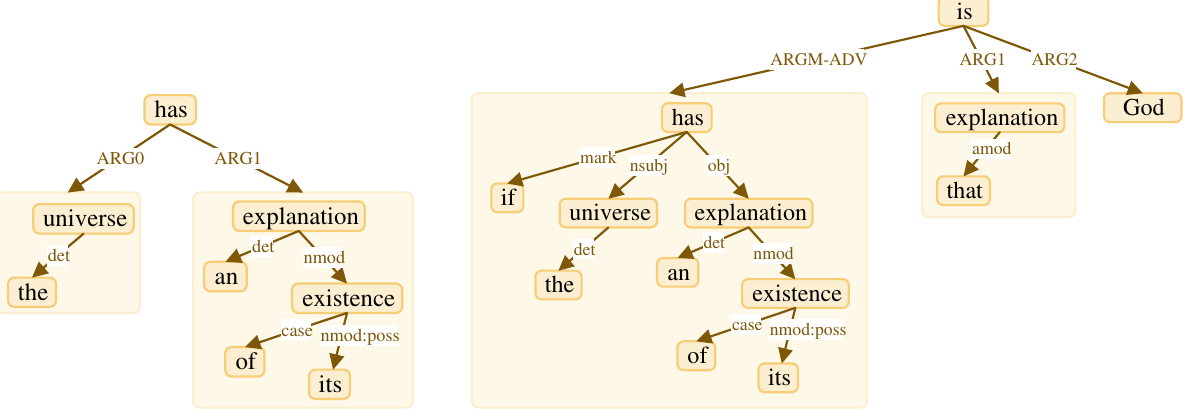
Figure 4. The subgraph of the arguments illustrated in Fig. 3.